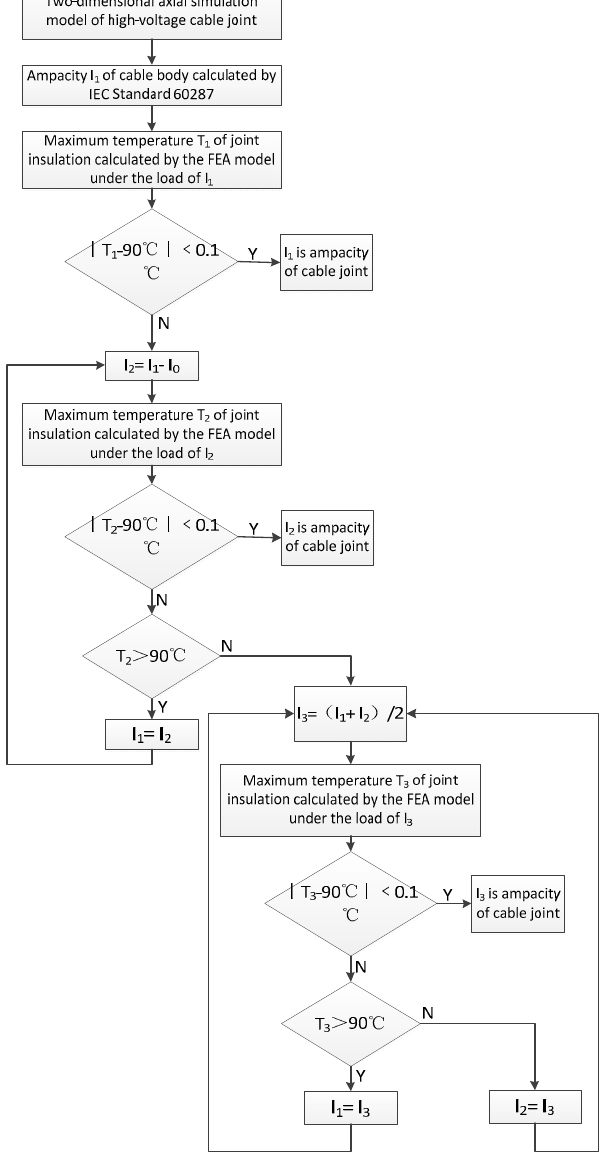
Figure 16. Algorithm for calculating cable joint ampacity. FEA denotes finite element analysis.